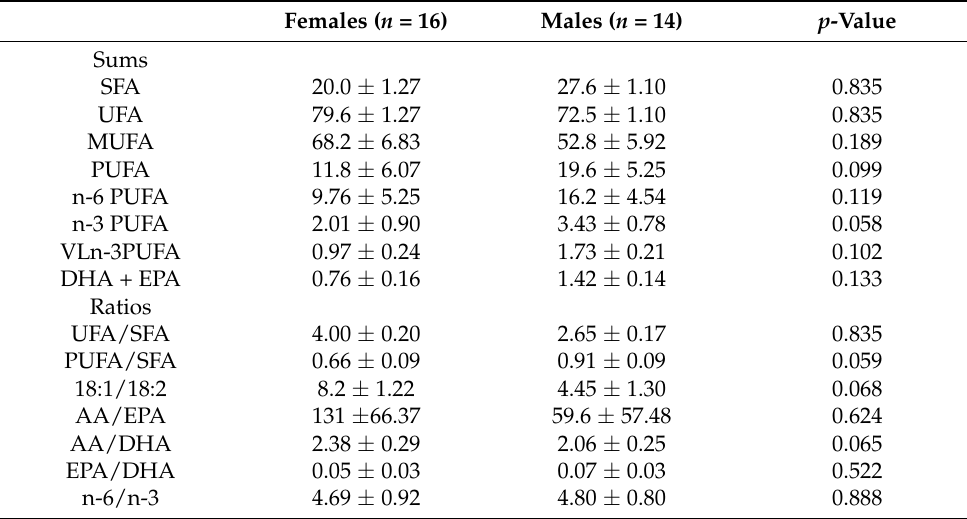
Table 2. Fatty acids (FA) sums (% of total FA) and FA ratios of edible dormouse ( Glis glis ) muscle ( m. biceps femoris